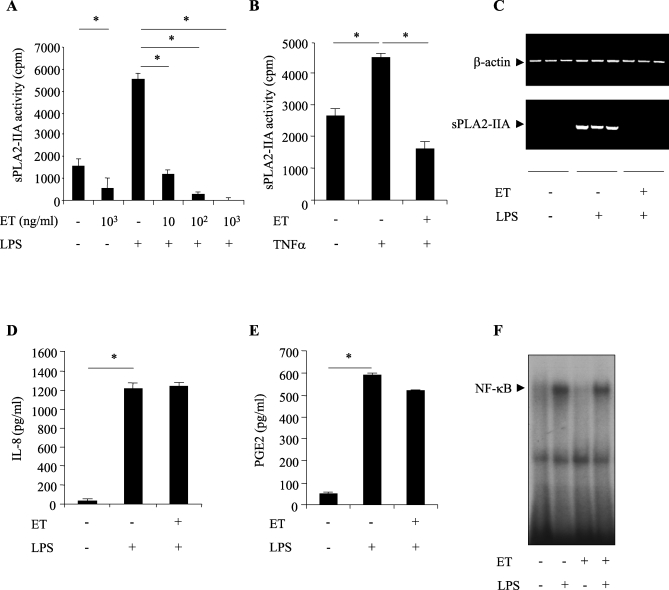
ET Impairs LPS-Induced sPLA2-IIA Expression, but Not IL-8, PGE2, and NF-κB Translocation(A) AMs were pretreated with ET (PA + EF) for 1 h before overnight stimulation with P. aeruginosa LPS (50 ng/ml). ET consisted of a fixed concentration of PA (1 μg/ml) and increasing concentrations of EF.(B) AMs were incubated with 1 μg/ml of ET (PA 1 μg/ml + EF 1 μg/ml), and were then stimulated overnight with TNFα (500 ng/ml). The sPLA2-IIA secretion levels were then assessed, as detailed in the Materials and Methods.(C–E) After 1-h pretreatment with 1 μg/ml of ET (PA 1 μg/ml + EF 1 μg/ml), followed by an overnight stimulation with LPS (50 ng/ml), sPLA2-IIA mRNA levels and IL-8 and PGE2 concentrations were measured in culture medium. (C) shows reverse-transcription PCR (RT-PCR) analysis of sPLA2-IIA mRNA expression of extracts from three independent experiments; (D) and (E) show IL-8 and PGE2 concentrations, respectively.(F) AMs were incubated with ET for 1 h and then were stimulated with LPS. After a 2-h incubation, NF-κB translocation was measured by EMSA.The data are the mean ± standard error of the mean (SEM), and are representative of four separate experiments. An asterisk (*) indicates p < 0.05.